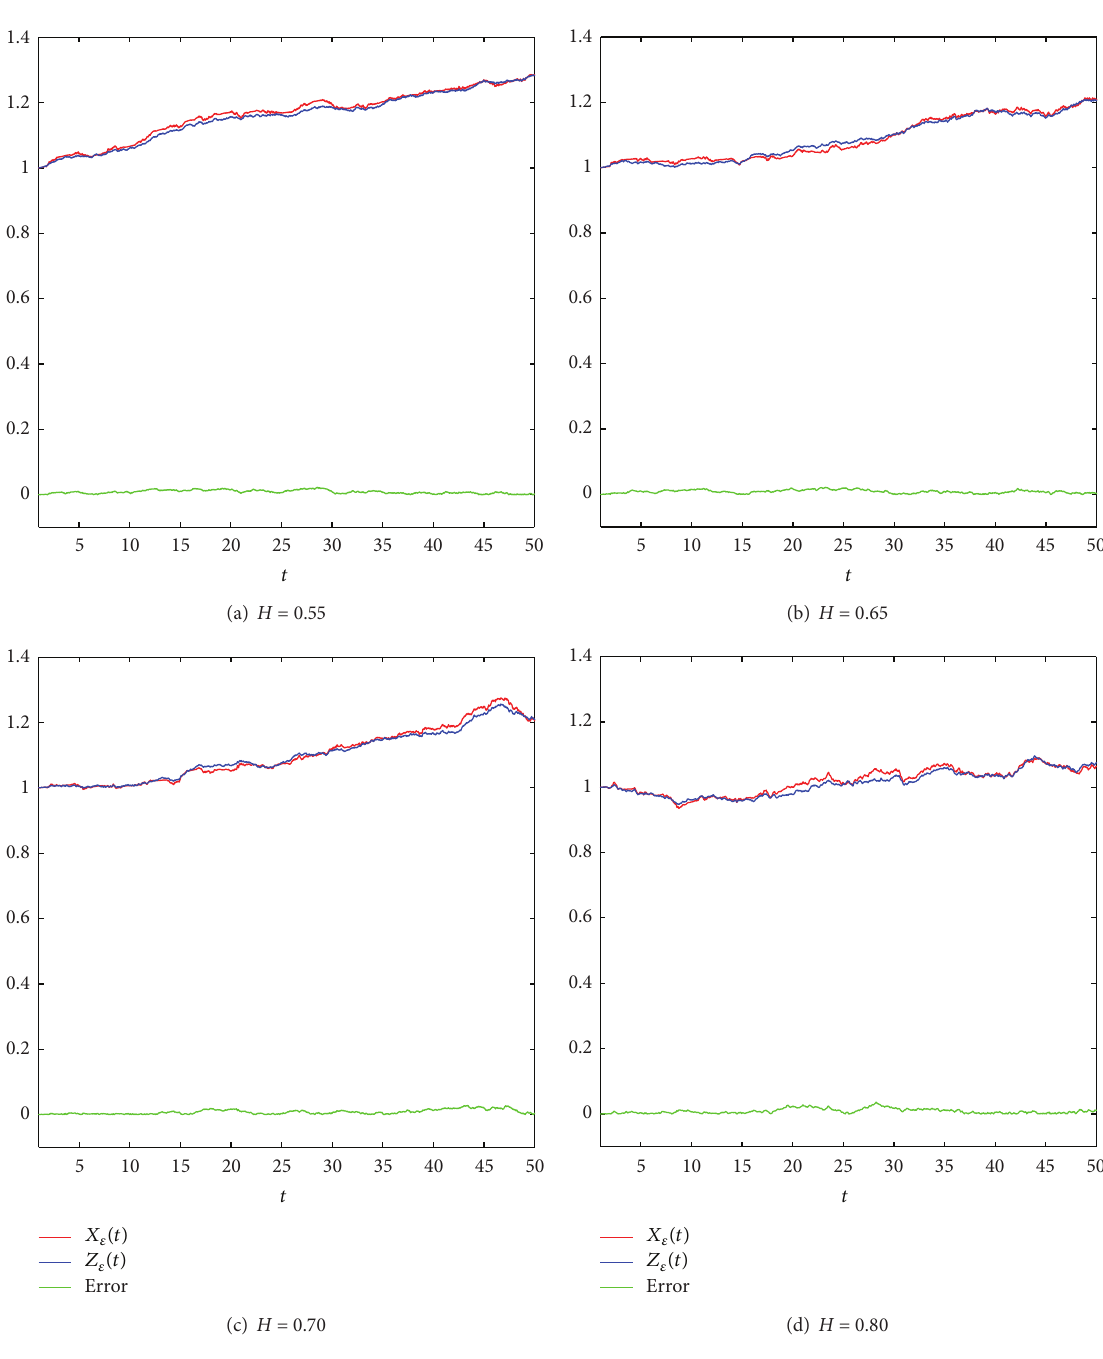
Figure 2: Comparison of the exact solution 𝑋 𝜀 (𝑡) with the averaged solution 𝑍 𝜀 (𝑡) for (55) and (58) with 𝑋(0) = 1 , 𝑎 = 0.2 , 𝑐 = 0.01 , 𝜀 = 0.045 , and different 𝐻